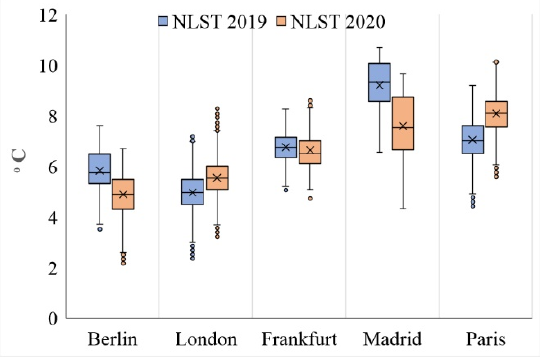
Figure 6. NLST characteristics in the studied cities during 2019 (blue) and 2020 (red). Table 1. Results of a paired-samples t -test for NLST data belonging to the studied cities for the two time